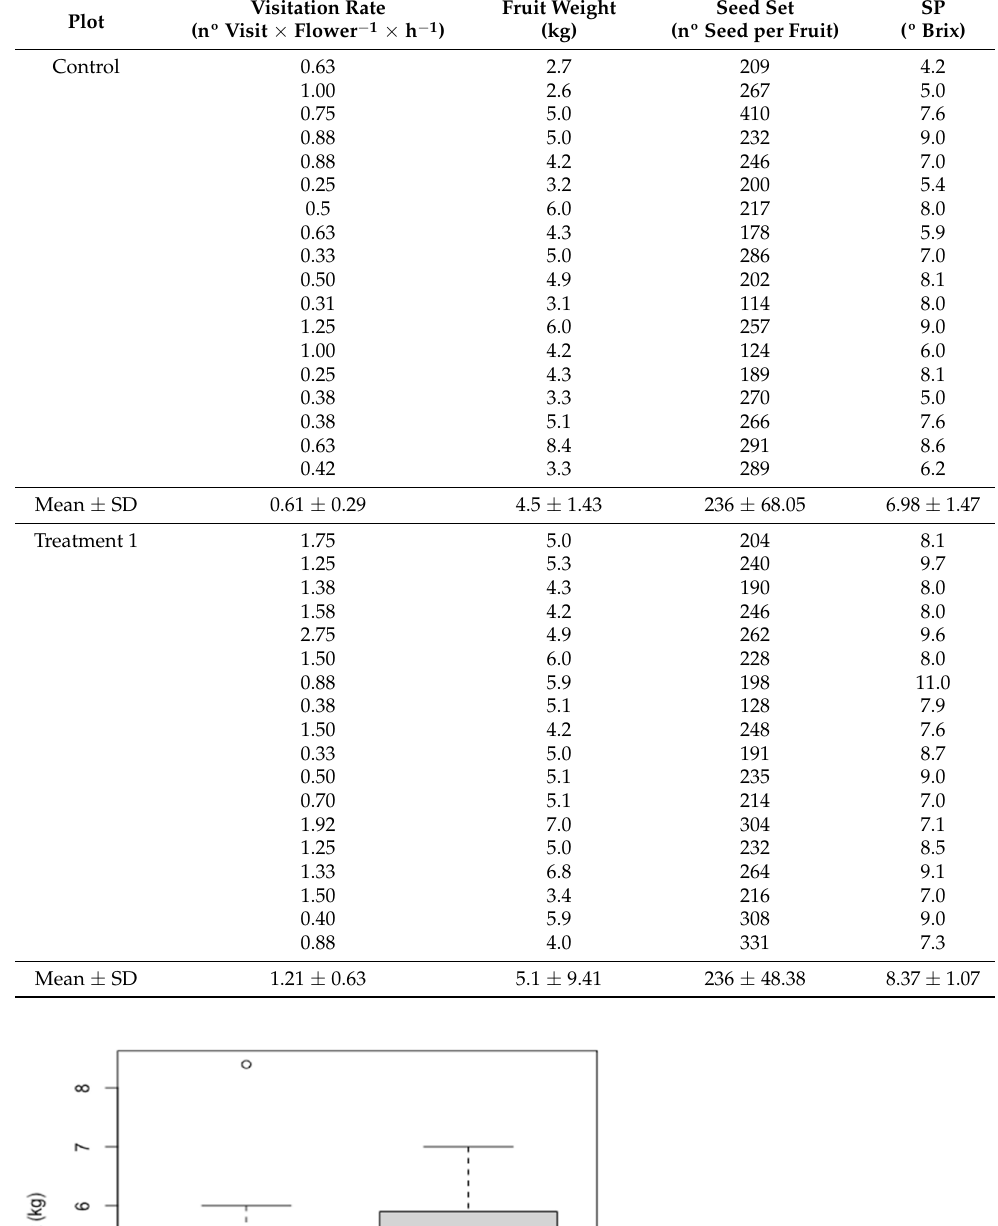
Table 1. Visitation rate, fruit weight, seed set, and solid solutes in pulp of C. maxima var. Paine in both experimental plots. Mean values and standard deviation are shown.